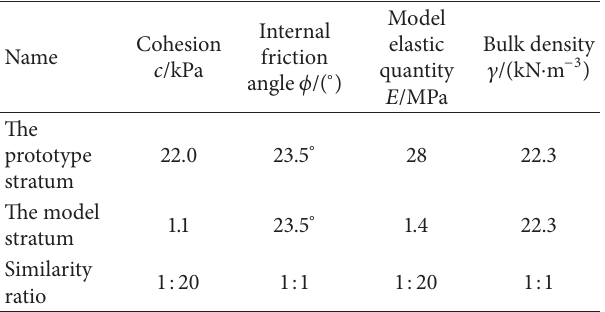
Table 2: Parameters of argillaceous siltstone strata in model and prototype.